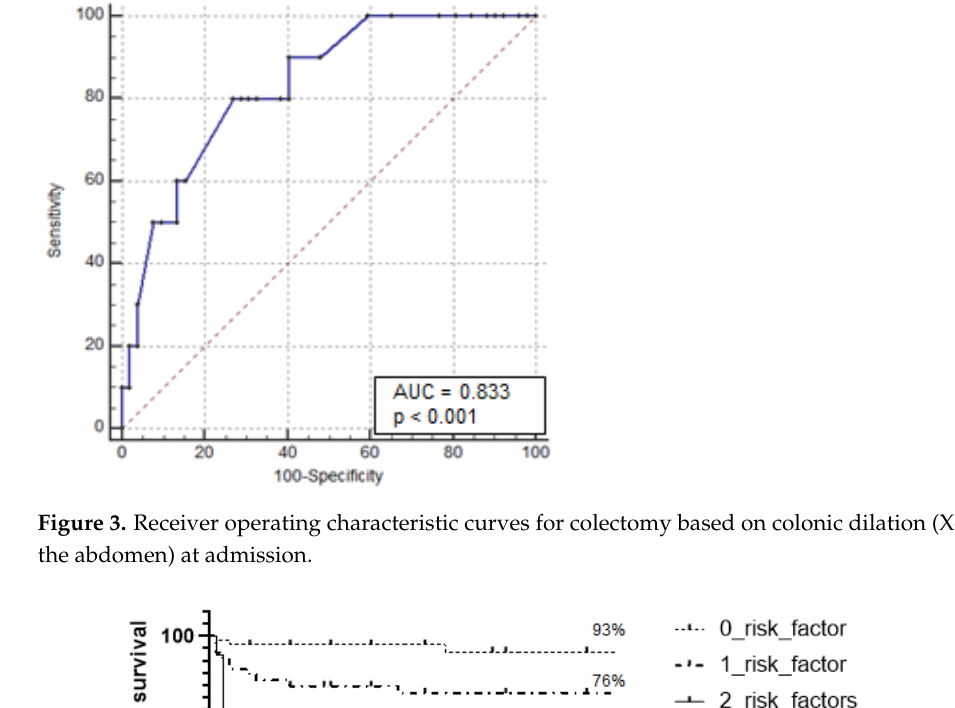
Figure 2. Receiver operating characteristic curves for colectomy based on the serum albumin levels at admission.